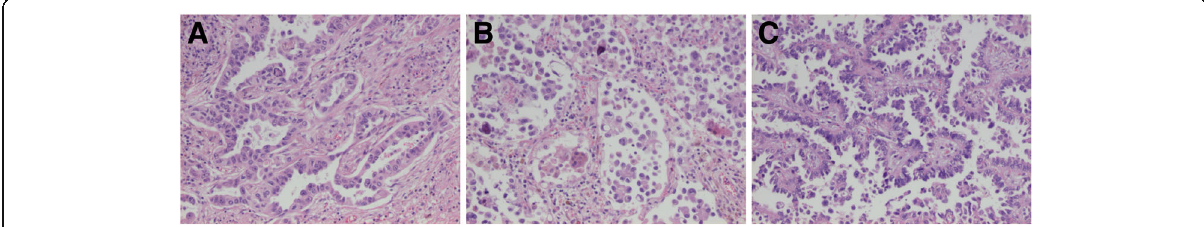
Fig. 5 Case 5. Lung adenocarcinoma with intrapulmonary metastasis with different growth patterns but identical BRAF mutation. a The central tumour with acinary and lepidic (not shown) growth patterns. b - c The subpleural tumour with micropapillary and papillary growth patterns. All images HE and x10